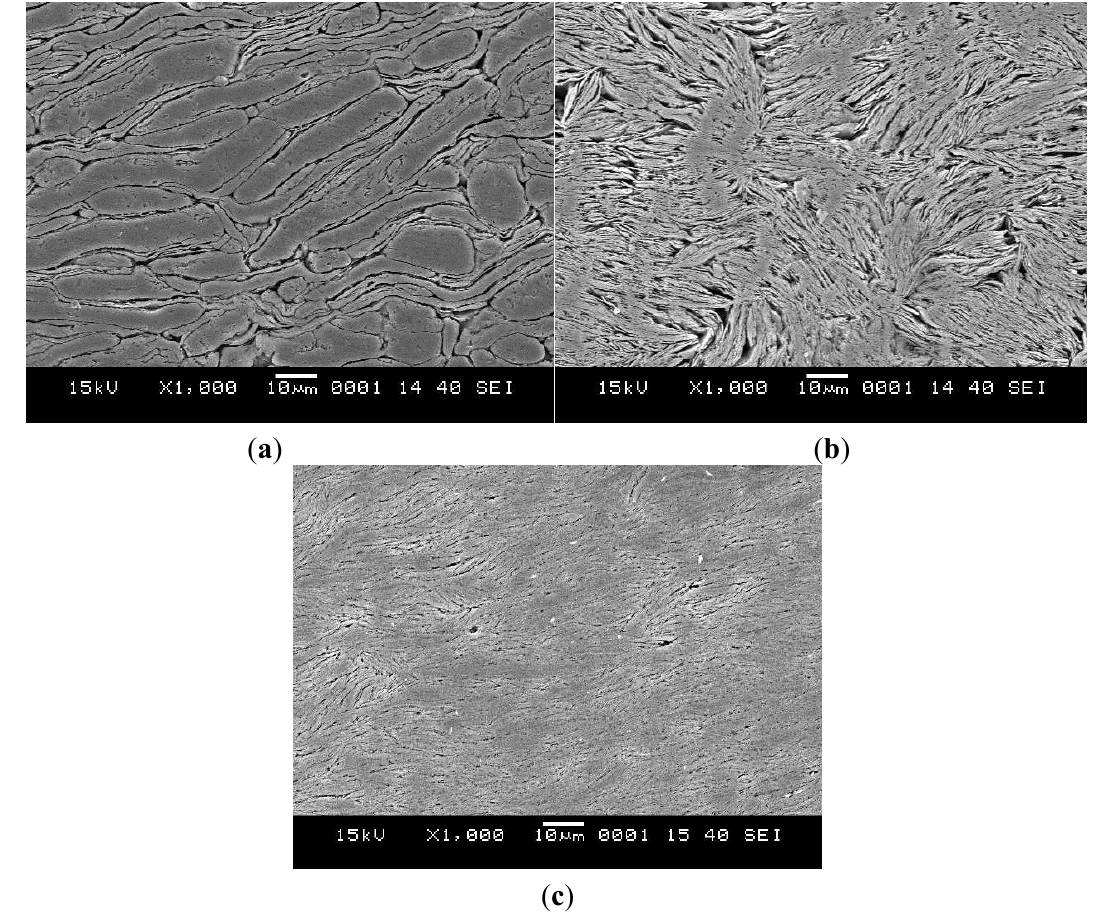
Figure 6. Microstructure of specimens sintered at ( a ) 500 °C, 200 °C/min, 50 MPa, 5